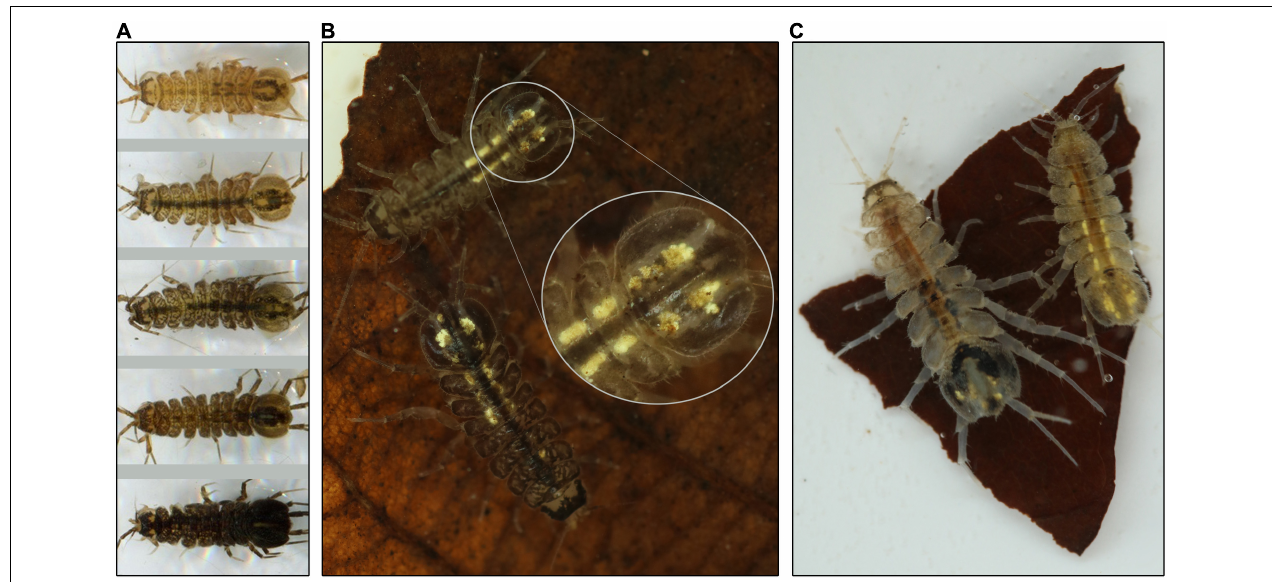
FIGURE 2 | Determinants of body pigmentation in Asellus aquaticus. (A) Images show differences in pigmentation between individuals of A. aquaticus . Pigmentation in this species is a highly variable trait, ranging from light to dark brown in surface water forms (e.g., Hargeby et al., 2004, 2005; Lürig et al., 2019) to nearly colorless cave forms (Protas et al., 2011). Similar to other isopods, integumental pigmentation is mainly composed of the ommochromes xanthommatin and ommatin, which are deposited inside specialized skin cells (Needham, 1970). (B) Image showing two individuals of A. aquaticus with visible Zenker cells, which are a specialized cell type homologous to the tegumental glands of terrestrial isopods (Ter-Poghossian, 1909; Gorvett, 2009). In A. aquaticus , the Zenker cells form conspicuous fluorescent yellow stripes along thoracic and abdominal segments (Zimmer et al., 2002b). Zenker cells help in the storage of metabolic waste products, such as uric acid, which appears in large amounts in A. aquaticus (Lockwood, 1959). The storage of uric acid, along with increased pigmentation, has been proposed as a mechanism to avoid cell toxicity (Linzen, 1974). Furthermore, the ecological relevance of the conspicuousness produced by Zenker cells has been associated with predation (Zimmer et al., 2002b), in that the fluorescence emitted by Zenker cells causes intraspecific variation in external patterns, affecting individual visibility, and influencing predation risk (Zimmer et al., 2002b). (C) Image of individuals of A. aquaticus infected with Acanthocephalan parasites, which have disruptive effects on the pigmentation patterns (Oetinger and Nickol, 1981). Infected individuals generally show darker pigmentation in the posterior-most region of the body (Needham, 1974; Dezfuli et al., 1994), making them more conspicuous (Dezfuli et al., 1994), and potentially influencing trophic transmission to the next host (i.e., different species of freshwater fish) (e.g., Hasu et al., 2007; Benesh et al.,